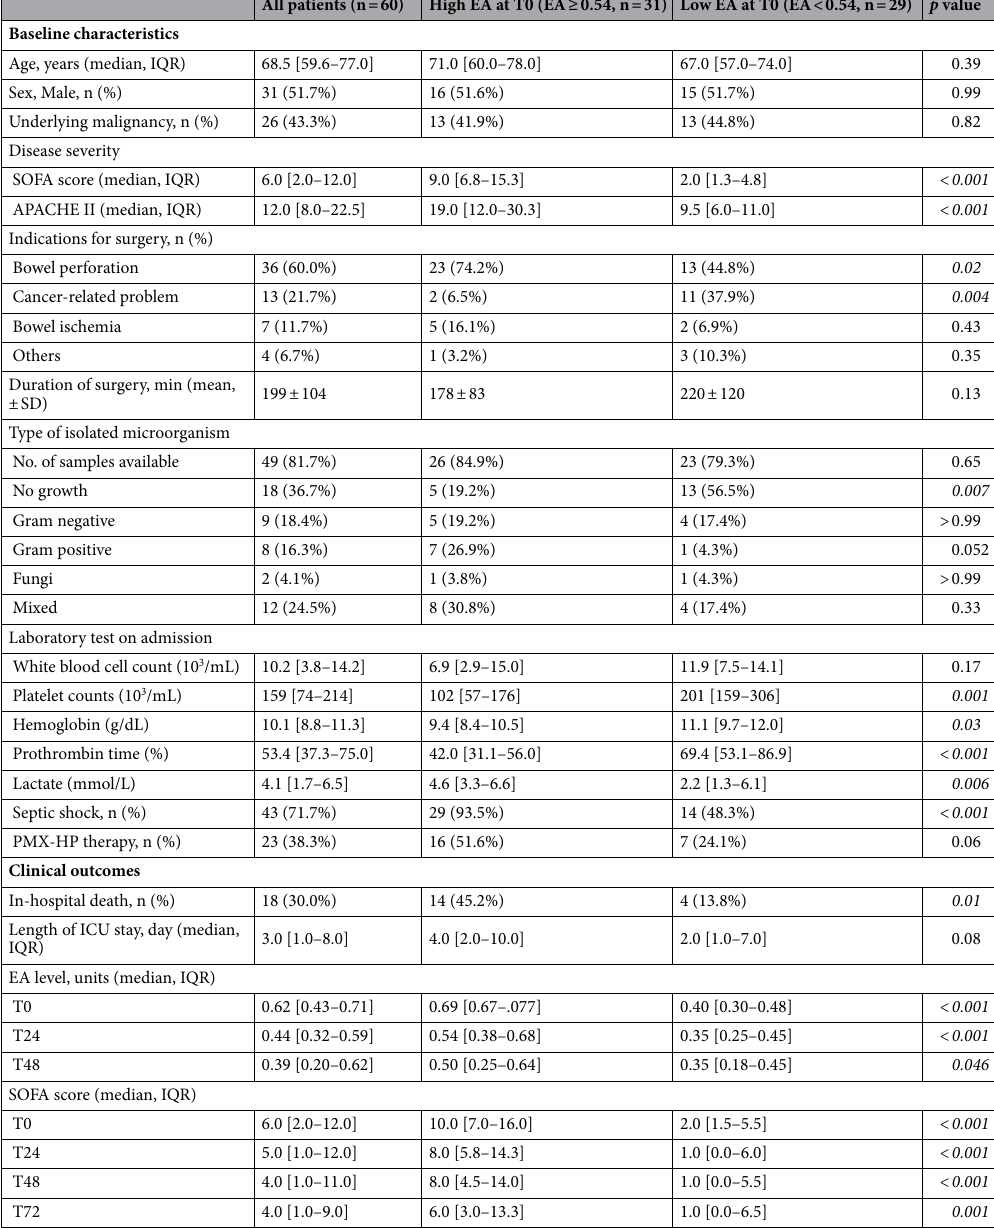
Table 1. Baseline characteristics and clinical outcomes of patients subdivided for EA levels measured at baseline (T0). APACHE Acute physiology and Chronic Health Evaluation, EA Endotoxin activity,